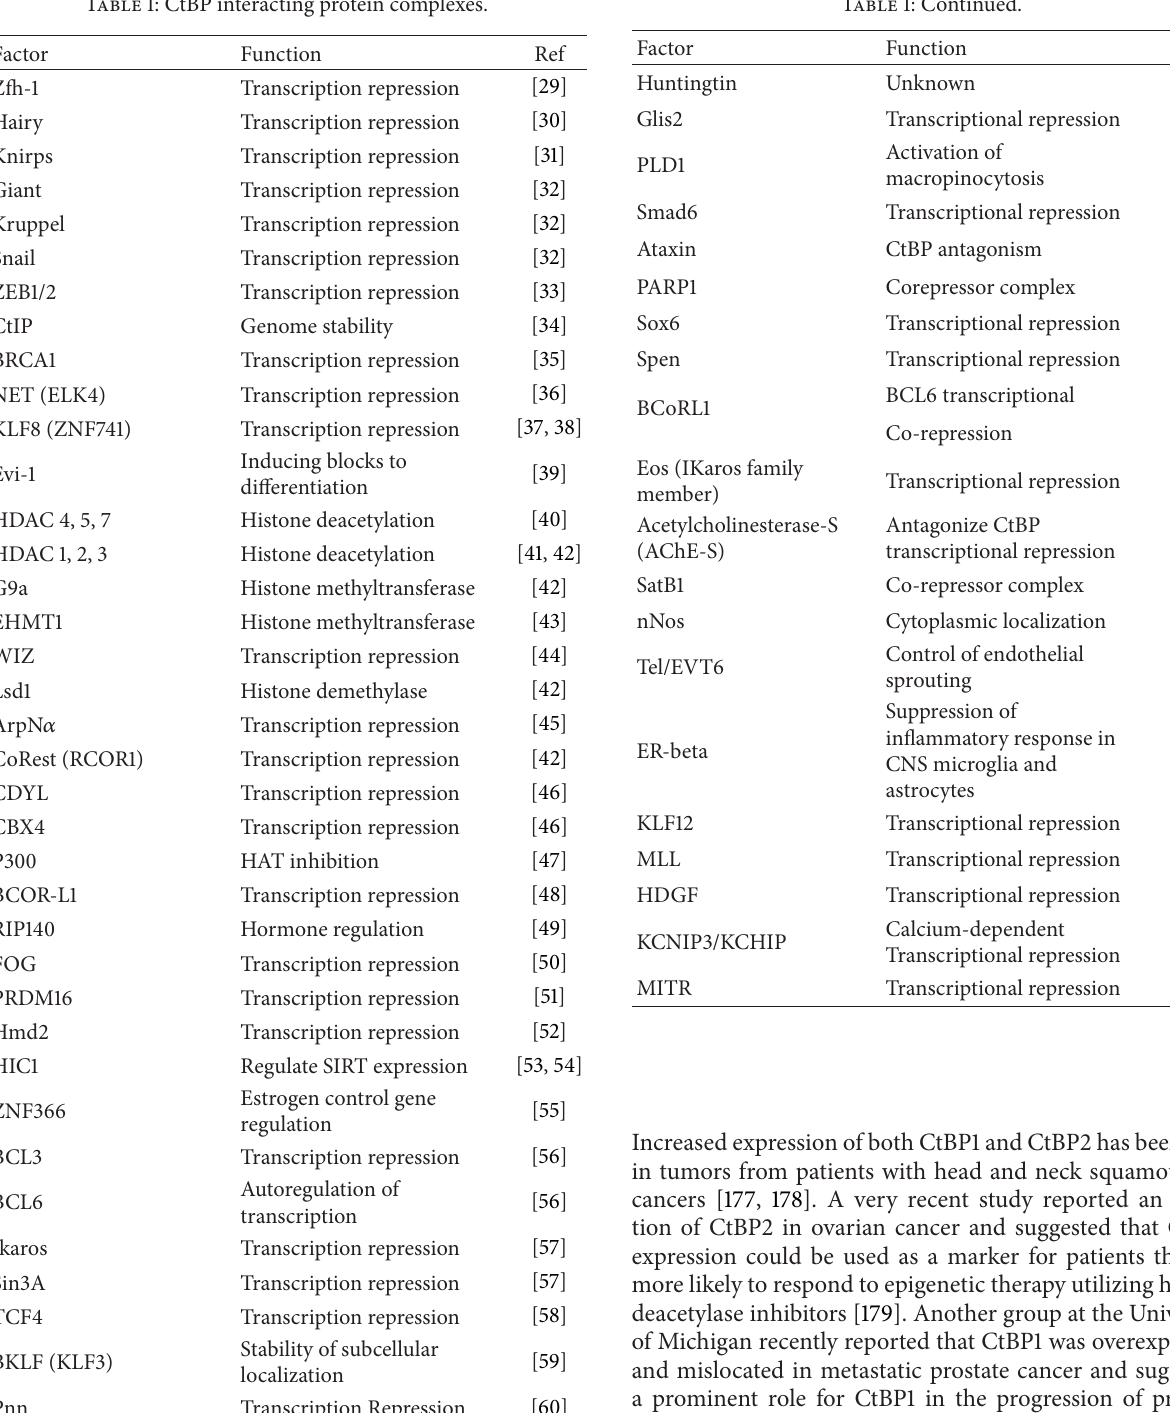
Table 1: CtBP interacting protein